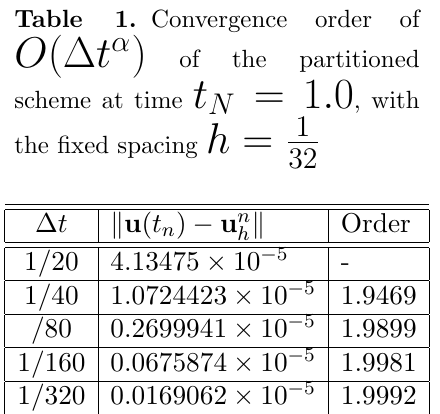
Table 1. Convergence order of O (∆ t α ) scheme at time the fixed spacing